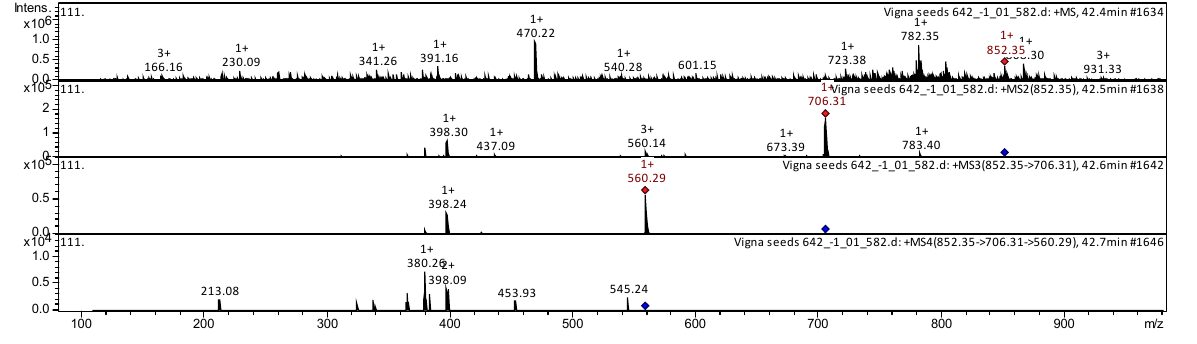
Figure 2. Mass spectrum of the steroidal alkaloid α -chaconine from V. unguiculata extract, at m/z 852.35.